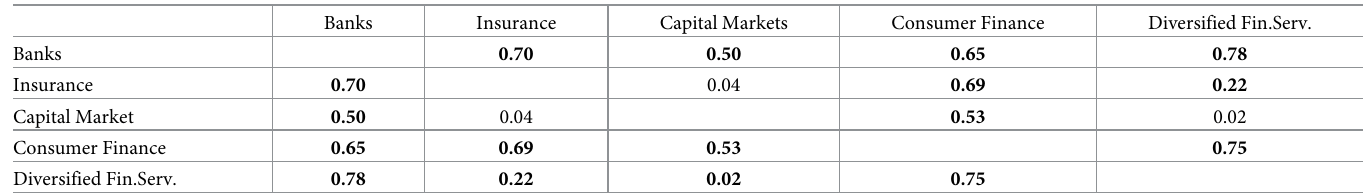
Table 4. Financials industry.